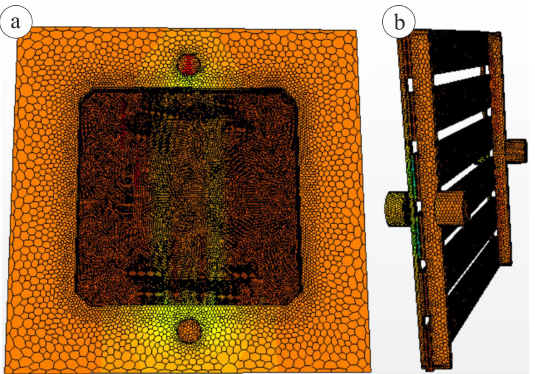
Fig. 4. Model of the test module for numerical calculation in Simcenter STAR-CCM+: a) polyhedral mesh view, b) fluid region flowing in ‘hot’ minichannel and ‘cold’ minichannel.